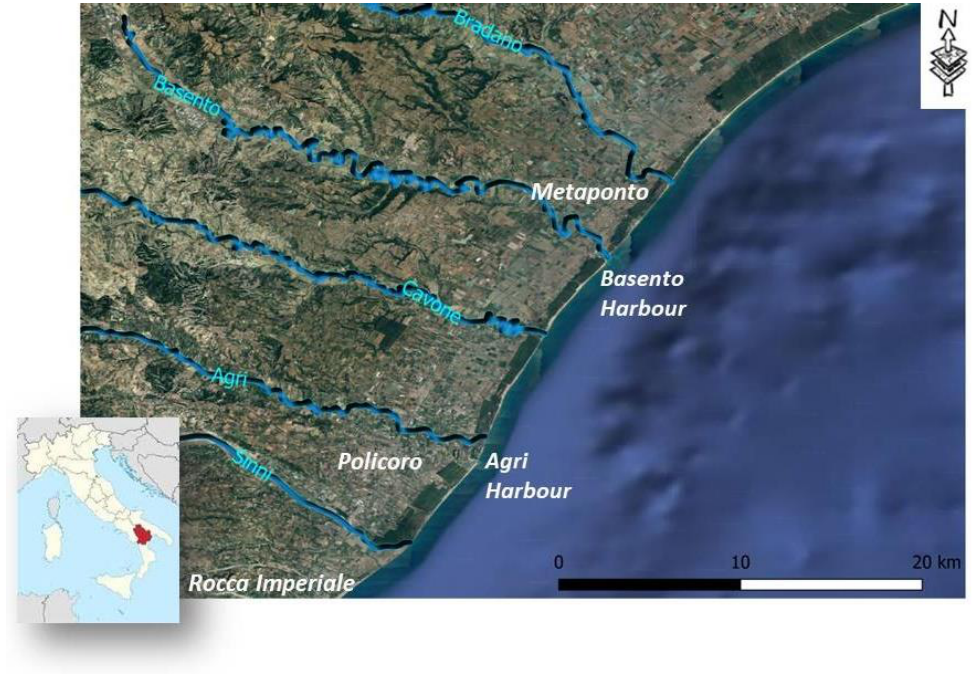
Figure 1. Case study area of the Lucana coast (Basilicata region, South Italy) (adapted from Google Earth).